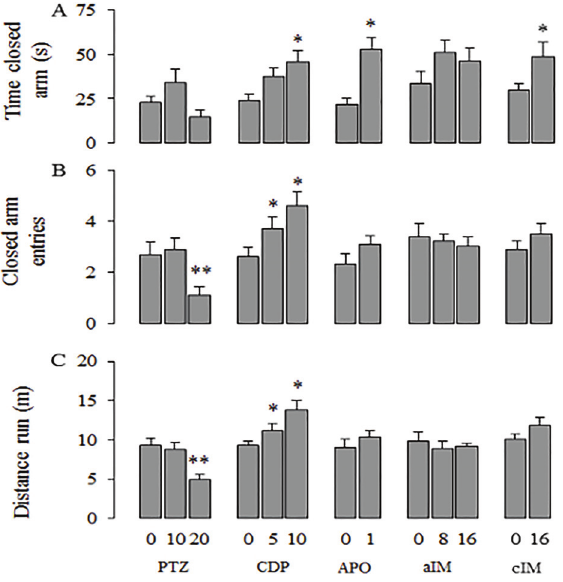
Figure 3. Effects of pentylenetetrazole (PTZ), chlordiazepoxide (CDP), apomorphine (APO), acute imipramine (aIM), and chronic